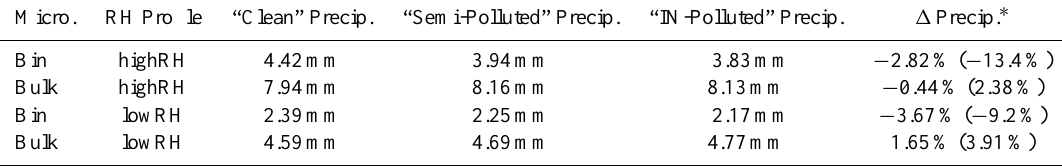
Table 3. Domain-averaged cumulative precipitation at the completion of the simulations performed including potential IN effects, t = 6h. Micro. “Clean” Precip.